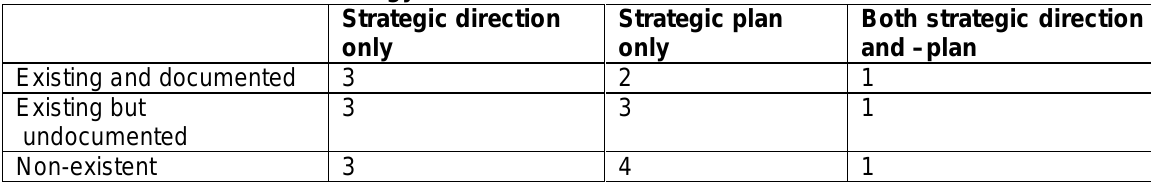
Table 4: Formalisation of